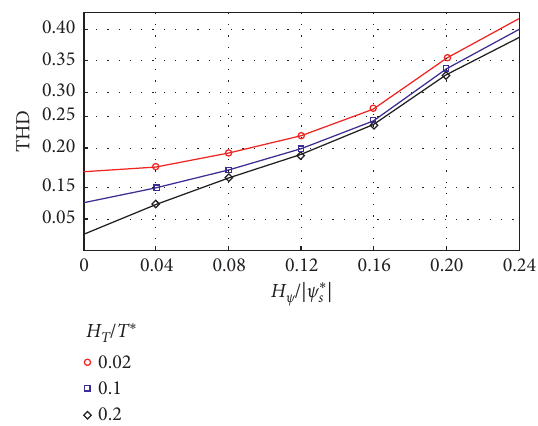
Figure 15: Total harmonic distortion as a function of the flux ( H and torque ( H T ) hysteresis bands. when the flux band was set to 2% of the reference value (0.8 Wb), and the torque band was set to 1% of the ref- erence value. The output torque signal is shown in Figure 16.